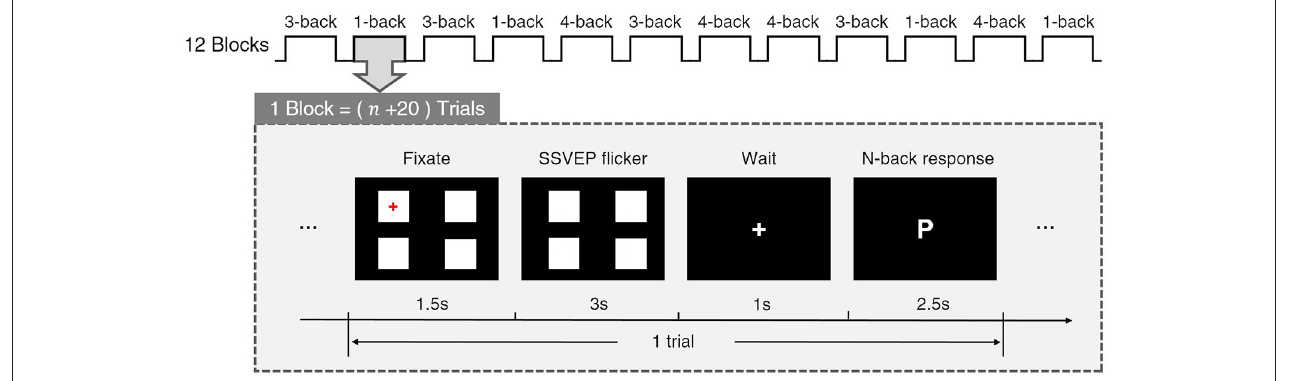
FIGURE 1 | Experimental procedure. During SSVEP flicker period, four stimulus squares flickered with the frequency of 7, 11, 13, and 15Hz